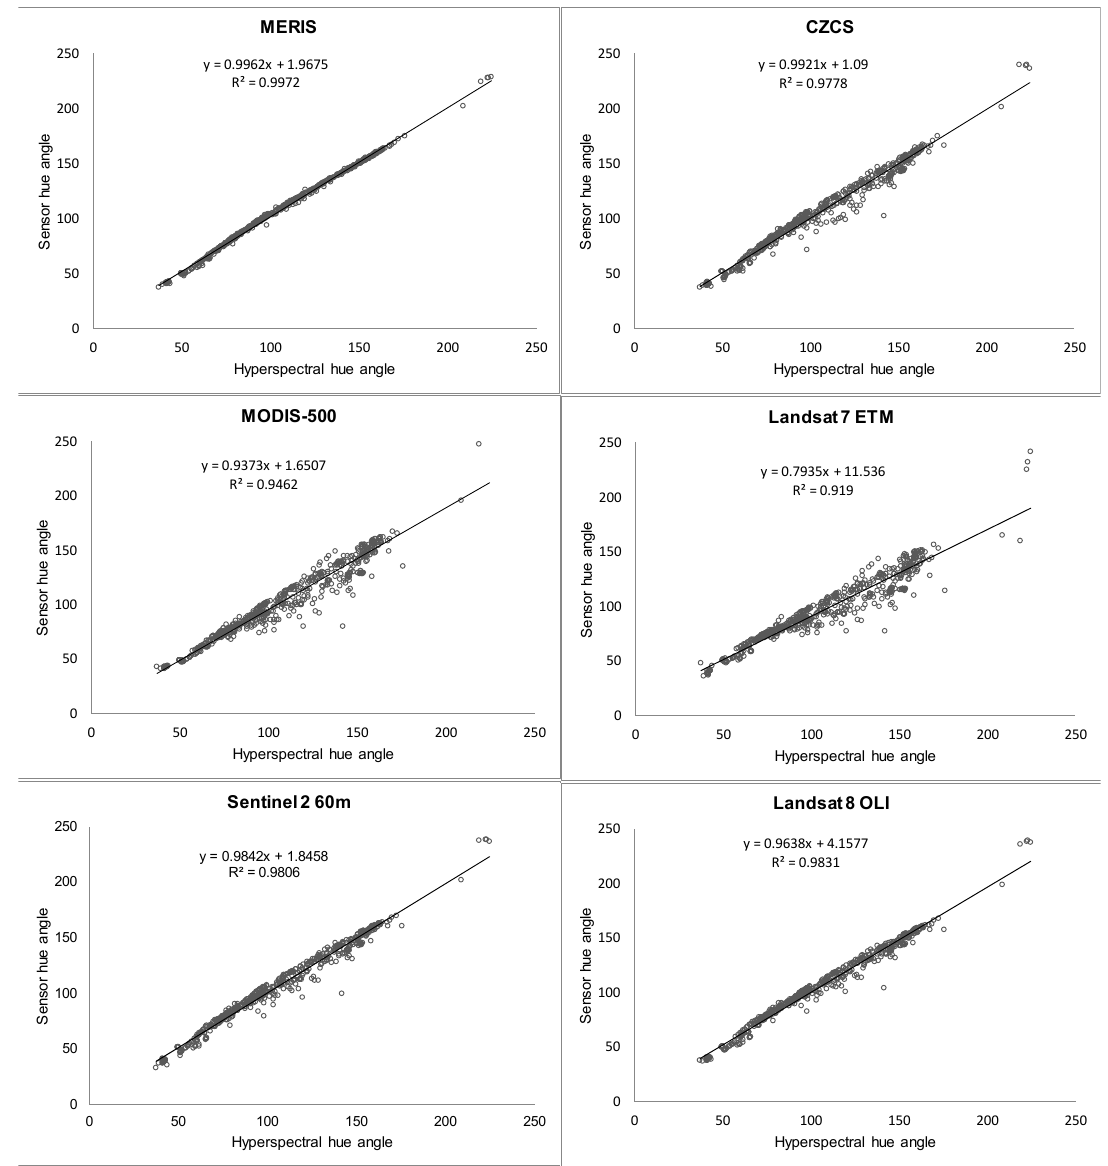
Figure 5. Validation of the hue angle reconstruction for six instruments.